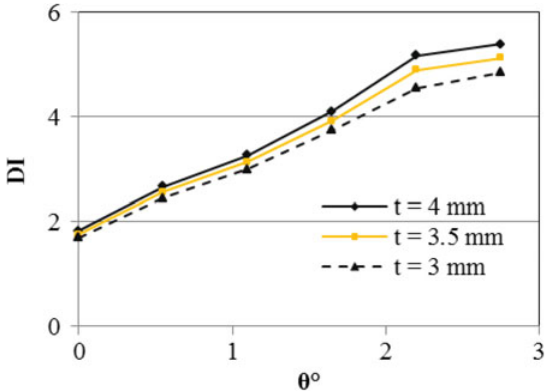
Fig. 8. Effects of tapered angle and steel wall thickness on